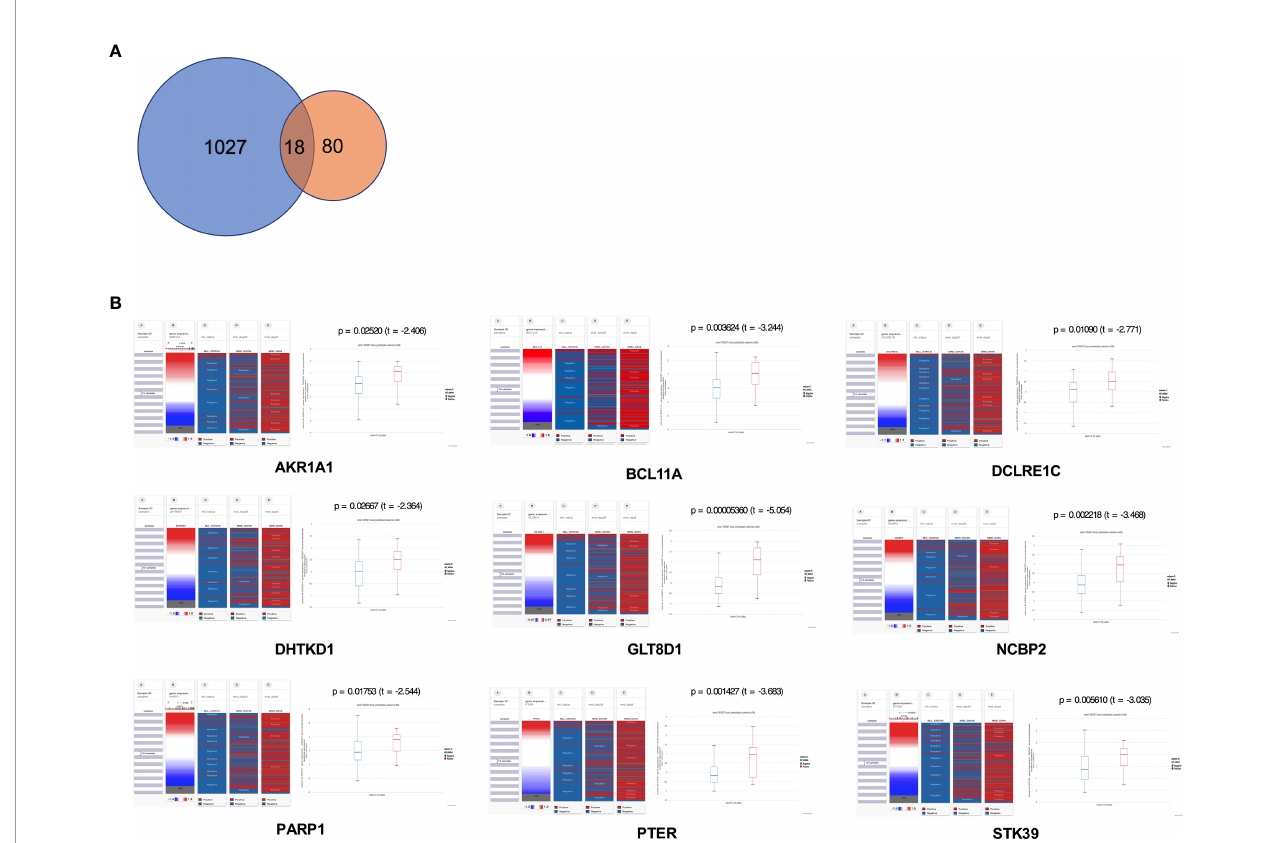
FIGURE 6 | The expression level of key hub genes in childhood MLL -r ALL. (A) The Venn diagram showed hub genes identi fi ed from DEGs and WGCNA. (B) Expression of AKR1A1 , BCL11A , DCLRE1C , DHTKD1 , GLT8D1 , NCBP2 , PARP1 , PTER , and STK39 in MLL -r ALL was highly correlated with the MLL status in the TARGET ALL (Phase I) dataset ( p < 0.05). The red color represents positive status and the blue color represents negative status of MLL fusion and